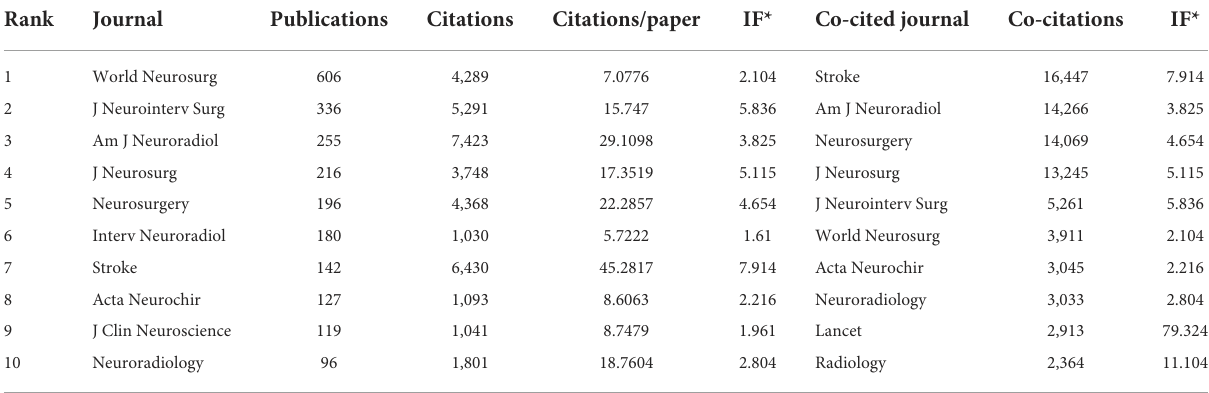
TABLE 1 The top 10 prolific journals and co-cited journals on IA research between 2012 and 2021. Rank Journal Publications Citations Citations/paper IF* Co-cited journal Co-citations